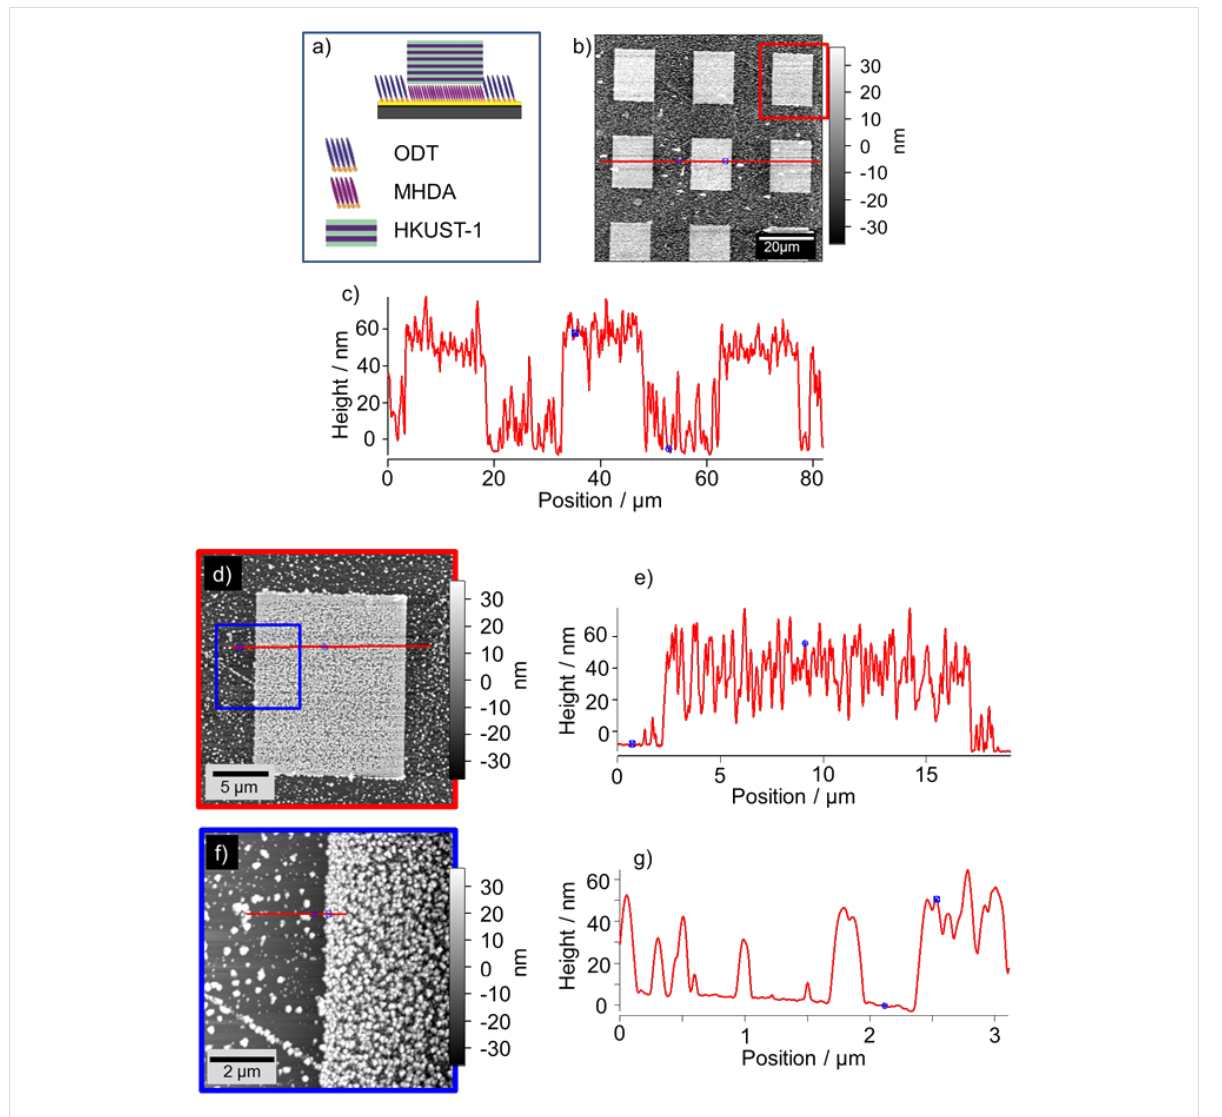
Figure 8: (a) Scheme of the layer cross-section of the AFM topography image of rectangular HKUST-1 structures site-selectively grown on the grafted MHDA areas. (b) AFM topography image of an array of rectangular HKUST-1 structures, grown on the MHDA terminated areas. (c) Cross section along the red line in (b). (d) and (f) detailed AFM topography images of the structure shown in (b) with the corresponding cross sections in (e) and (g),